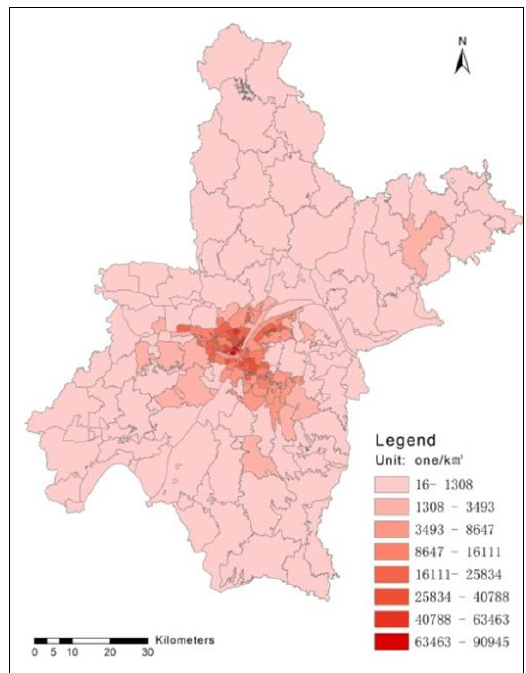
Figure 6. Spatial distribution map of the population density of Wuhan.